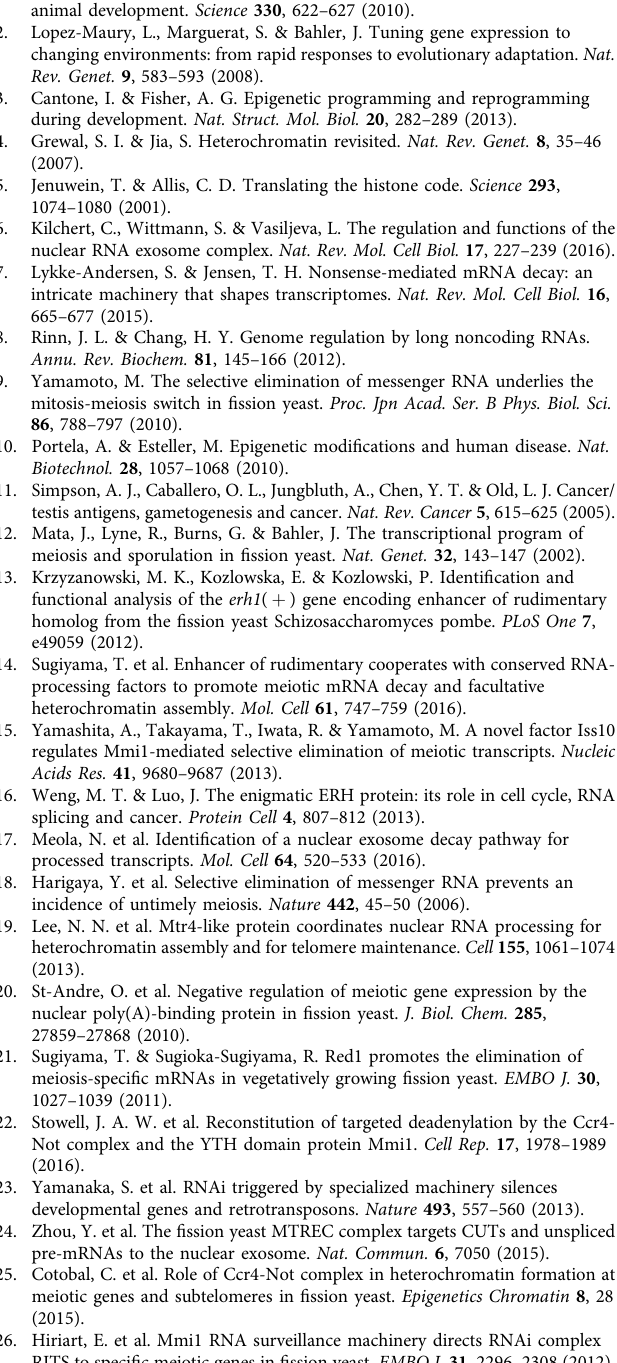
Supplementary Table 4. For ChIP-seq analyses, sequencing libraries were generated using NEBNext Ultra II DNA library prep kit for Illumina (NEB) according to the manufacturer ’ s protocol. Samples were multiplexed and single-end reads were sequenced on the Illumina NextSeq 500 platform. Adapter trimmed reads were aligned to the S. pombe v2.29 reference genome using BWA-MEM. Correction for GC-content bias and input normalization was performed using the Deeptools suite 57 functions correctGCbias and bamCompare. Plots were generated using the plotPro fi le function. RNA-seq and RT-PCR . Total RNA was prepared by harvesting 2 OD 595 of mid-log phase cells cultured in YEA medium at 32°C followed by fl ash-freezing in liquid nitrogen. RNA was isolated using the hot-phenol method in equal volumes of AES buffer (50mM sodium acetate pH 5.3, 10 mM DTA, 1% SDS) and acid-phenol. The mixture was incubated at 65 °C and vortexed every minute for 5minutes. After- wards, the slurry was transferred to Maxtract High Density tubes (Qiagen) and RNA was puri fi ed by chloroform extraction. Puri fi ed RNA was precipitated using Glycoblue (Thermo Fisher Scienti fi c), sodium acetate pH 5.3 and isopropanol. Total RNA was treated with DNase I (Thermo Fisher Scienti fi c) before subsequent analyses. For RNA-seq, ribosomal RNAs were depleted using the Ribo-Zero Gold rRNA Removal Magnetic Kit (Yeast) (Epicentre) prior to library construction using the NEBNext Ultra II Directional RNA library prep kit for Illumina (NEB) according to the manufacturer ’ s instructions. Single-end sequencing was per- formed on the Illumina NextSeq 500 platform. Adapter trimmed reads were aligned to the S. pombe v2.29 reference genome using Tophat2 58 . Minimum and maximum intron sizes were set to 30 and 817, respectively. Normalization by reads per kilobase per million (RPKM) and coverage plots were performed using the Deeptools suite function 57 bamCoverage and plotPro fi le. For differential analyses, FPKM values were determined for each of the 7019 genes using Cuf fl inks 59 . Upregulated genes were de fi ned as those with FPKM ratios ≥ 2 relative to WT. Heatmaps were generated using Java Treeview platform 60 . For RT-PCR experiments, cDNA was synthesized using Superscript III First- Strand Synthesis SuperMix (Thermo Fisher Scienti fi c) using oligo-dT. Subsequent qPCR analyses were performed using iTaq Universal SYBR Green Supermix (Biorad). Oligonucleotides used for RT-PCR are listed in Supplementary Table 4. smFISH . Single molecule RNA Fluorescence In-Situ Hybridization (smFISH) was performed with modi fi cations to the manufacturer ’ s protocol (Biosearch Tech- nologies) and as described 61 . Mid-log cells were fi xed in 3.7% formaldehyde and treated with Zymolyase 100T for partial cell wall digestion. The cells were per- meabilized in 70% ethanol and incubated overnight with probes against ssm4 mRNA. CAL Fluor Red 590 labeled ssm4 probes were designed using Stellaris Probe Designer tool (Supplementary Table 4) and synthesized by Biosearch Technologies. Stellaris RNA FISH hybridization and wash buffers were obtained from Biosearch Technologies. Cells were mounted in ProLong Gold antifade reagent with DAPI (Life Technologies) and imaged using a DeltaVision Elite fl uorescence microscope (Applied Precision, GE Healthcare) with Olympus 100×/ 1.40 objective. Optical Z sections were acquired (0.2 µ step size, 20 sections) for each fi eld. Images were deconvolved and all Z -stacks were projected into a single plane as maximum-intensity projections. Fiji (ImageJ) software was used for analysis. Cell boundaries were marked manually and the distribution of ssm4 mRNA spots was calculated manually. Northern blot analysis . Northern blot analysis was performed using total RNA isolated as described above for RNA-seq analyses. Ten microgram of total RNA